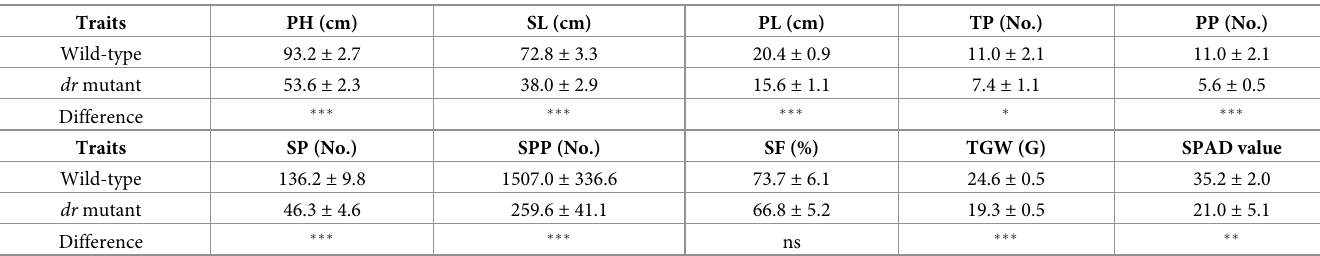
Table 1. Agronomic traits of wild-type and dr mutant. Traits